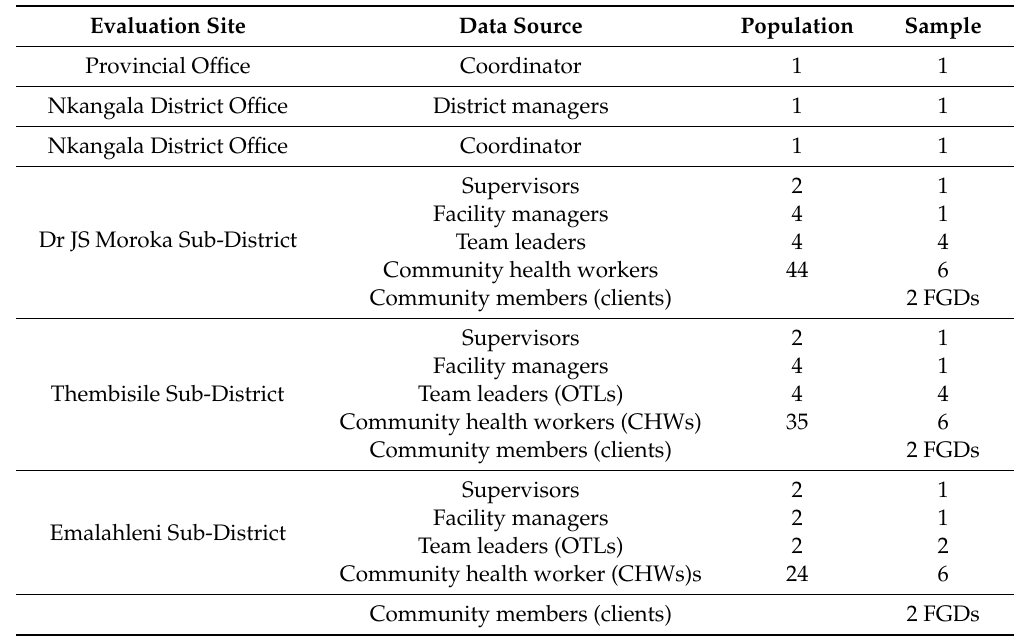
Table 1. List of data sources and evaluation